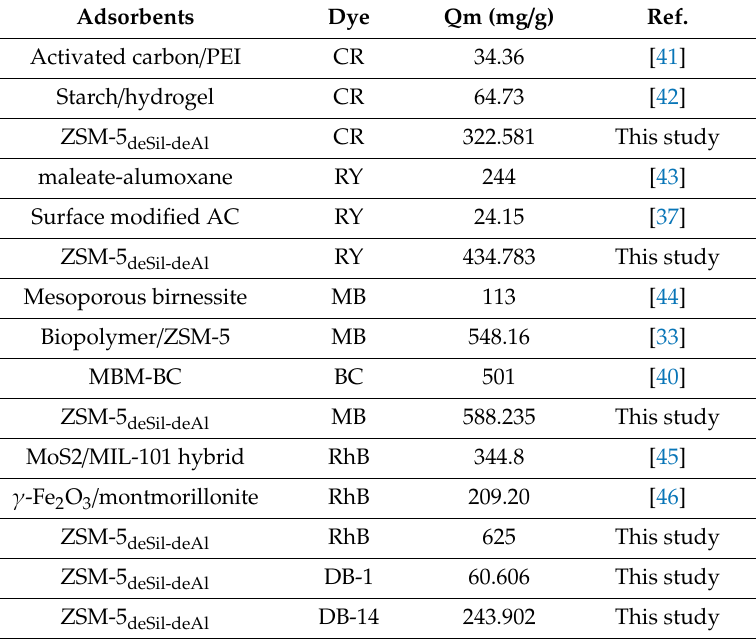
Table 6. Comparison of existing study with several earlier